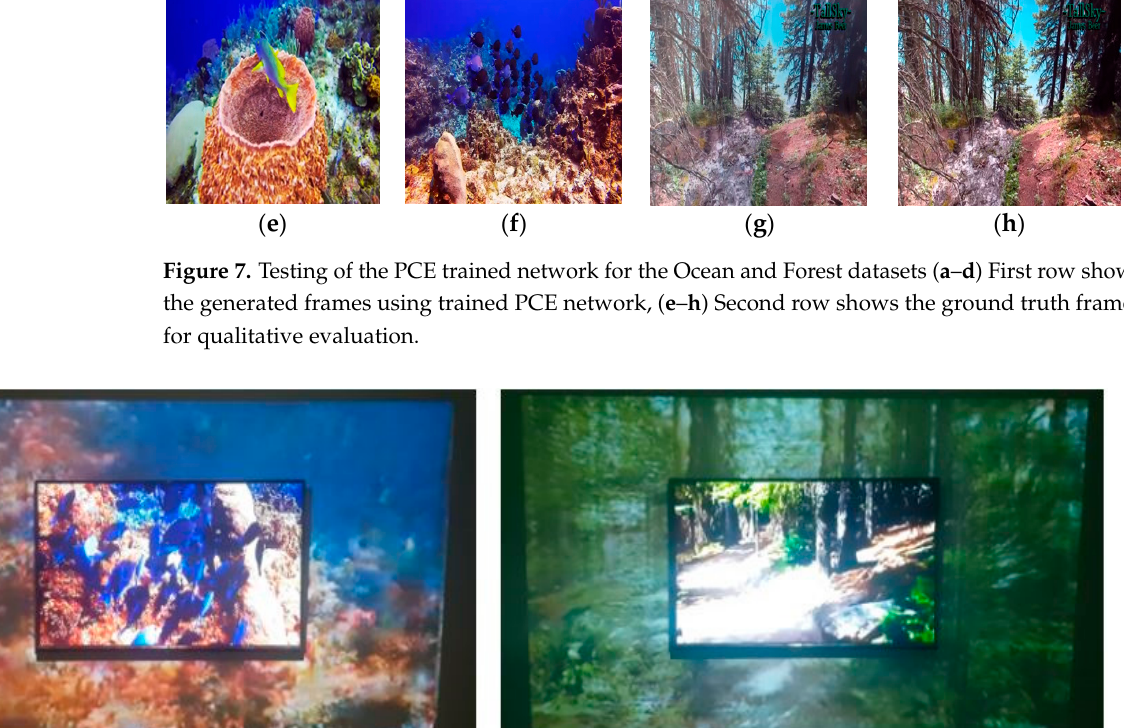
Figure 8. The snap shots of the Demos conducted in the Testbed for Ocean and Forest datasets with video links. (https://drive.google.com/open?id=1uUsAVfdWiqesX7eY1cmZyTCFEghJmFxP